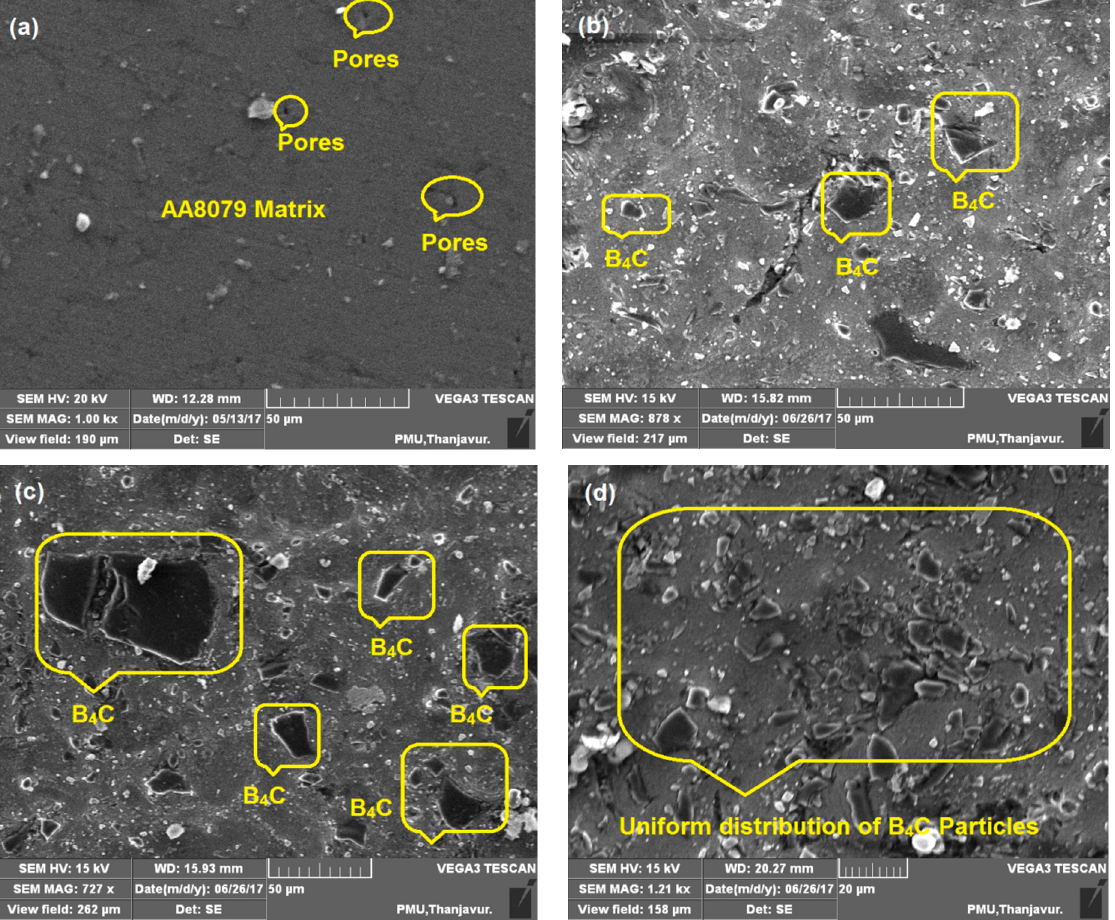
Figure 4. SEM images of sintered ( a ) AA8079, ( b ) AA8079-5 wt.%B 4 C, ( c ) AA8079-10 wt.%B 4 C, and ( d ) AA8079-15 wt.%B 4 C composite preforms.